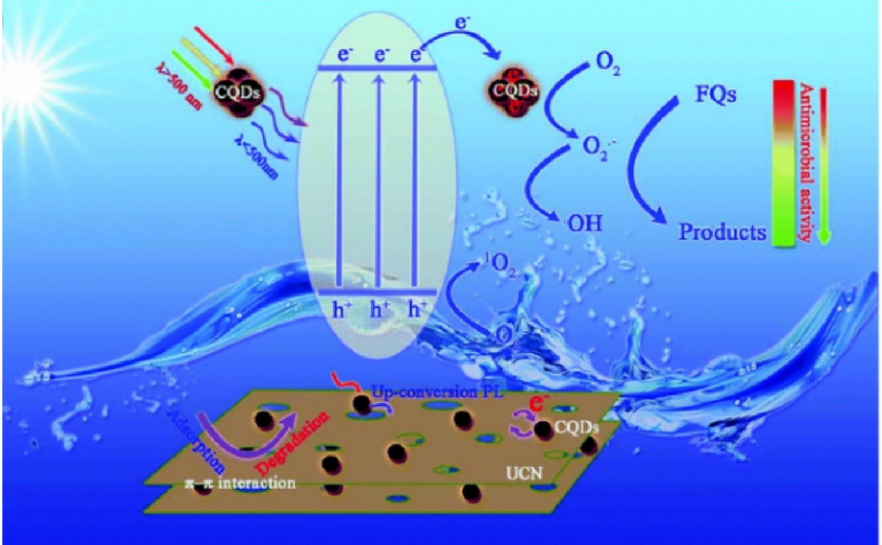
Figure 16. Mechanism of photocatalytic degradation of OFX by mpg-C 3 N 4 /CQDs